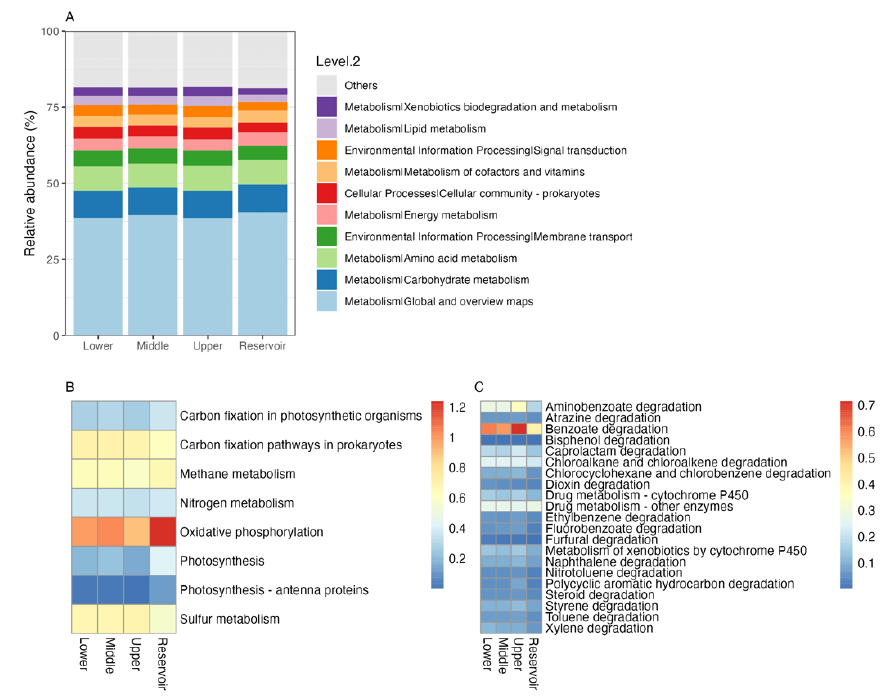
Figure 9. Function prediction obtained by Tax4Fun2. ( A ) Functional gene pathways at KEGG level2; ( B ) relative abundance of functions under the energy metabolism category; ( C ) relative abundance of functions under the xenobiotics’ biodegradation and metabolism category.